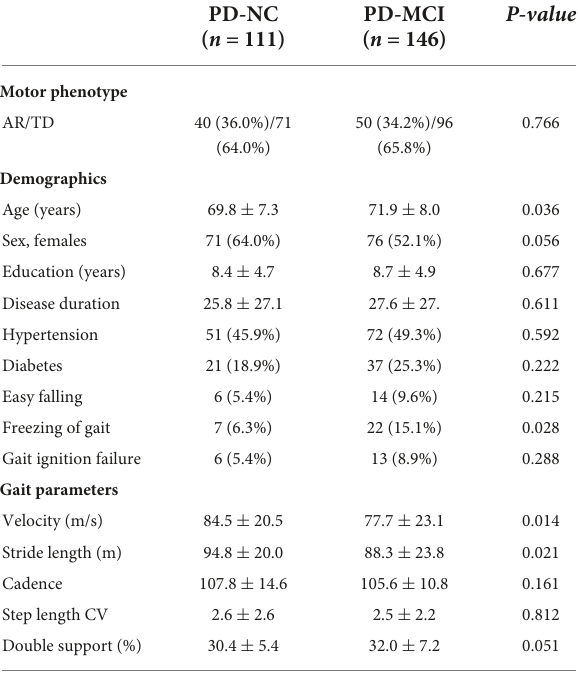
TABLE 1 Demographic variables and gait profiles of study participants.